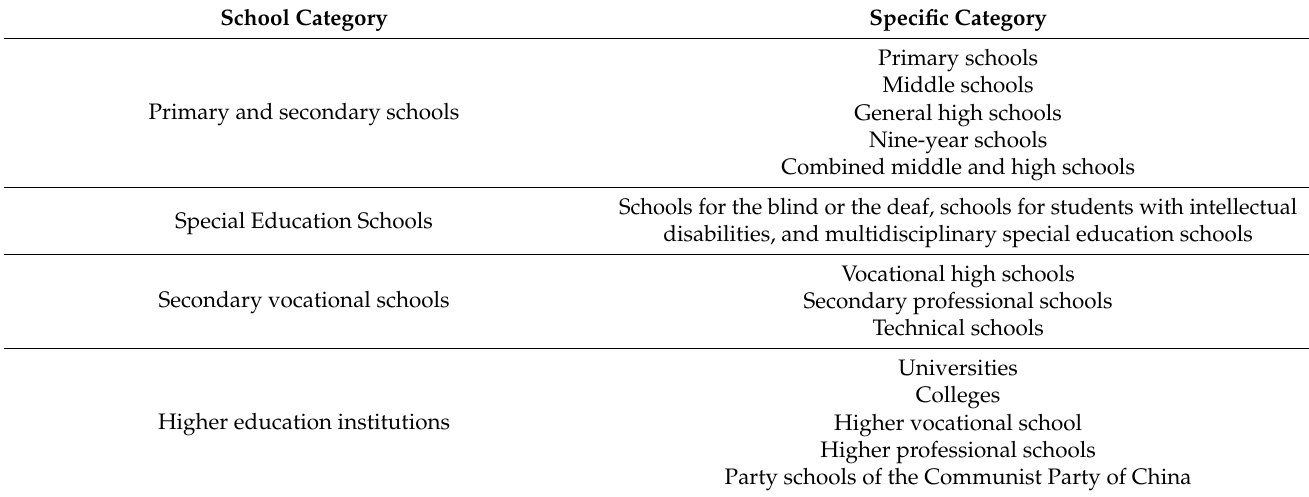
Table 1. Facility categories in the Standard for Urban Public Service Facilities